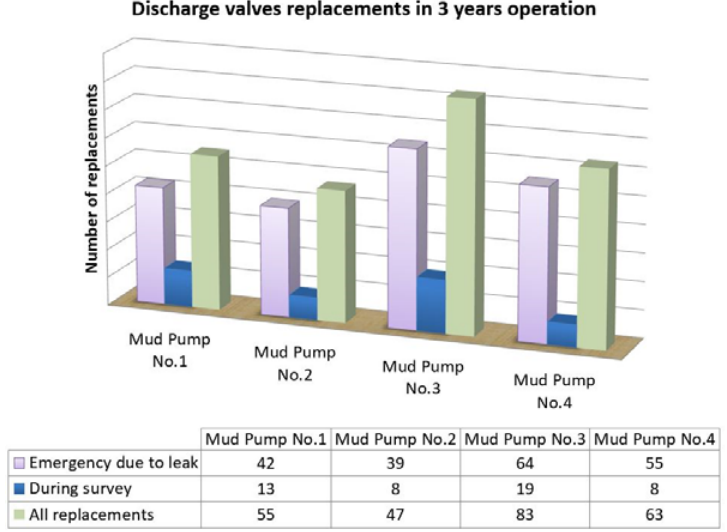
Figure 3. Analysis of the replacements of mud pump discharge valves on drillships [6,7].